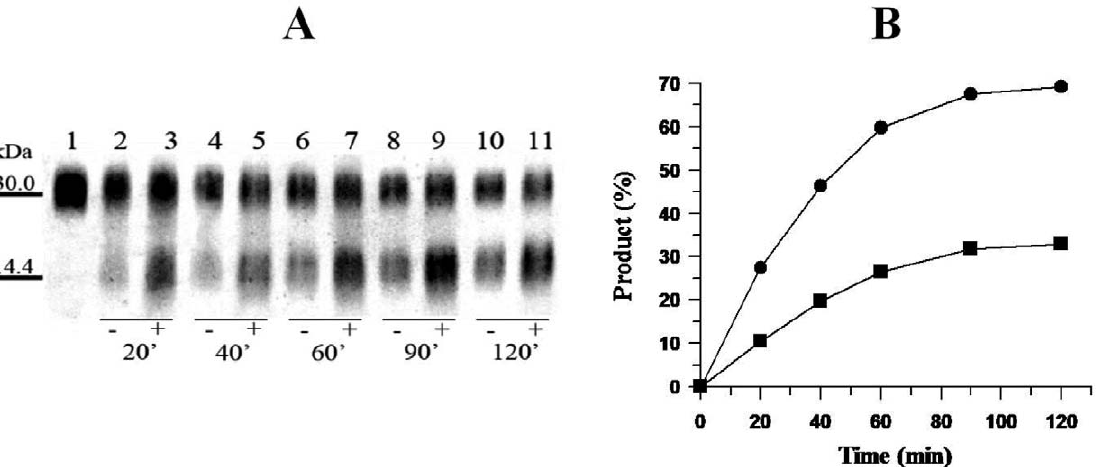
Figure 1. Heparin up-regulates TIMP-1 proteolysis by HNE. A , TIMP-1 (220 m g/ml) was allowed to react with 0.55 m g/ml HNE at 37 u C in absence (lanes 1, 2, 4, 6, 8 and 10) or in presence (lanes 3, 5, 7, 9 and 11) of 50 m M heparin. The reaction was performed in 100 mM Tris-HCL, pH 7.4, containing 100 mM NaCl, and 0,05% Triton X-100. Aliquots from both samples were collected at 20, 40, 60, 90 and 120 minutes and the reaction was N stopped by inactivation of HNE with PMSF. TIMP-1 fragments were analyzed by SDS-PAGE under reducing conditions and visualized by silver staining. ) or in the absence of heparin ( & ) is plotted as a function of time of reaction with HNE after gel B , the extent of TIMP-1 cleavage in the presence ( densitometry.